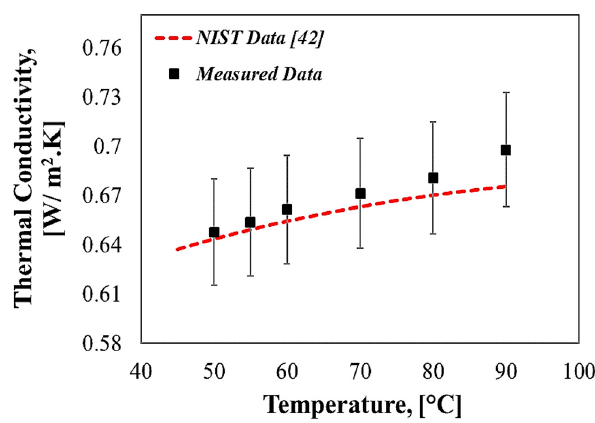
Figure 7. The validation of thermal conductivity results for deionized water with National Institute for Standard and Technology (NIST) data [42].